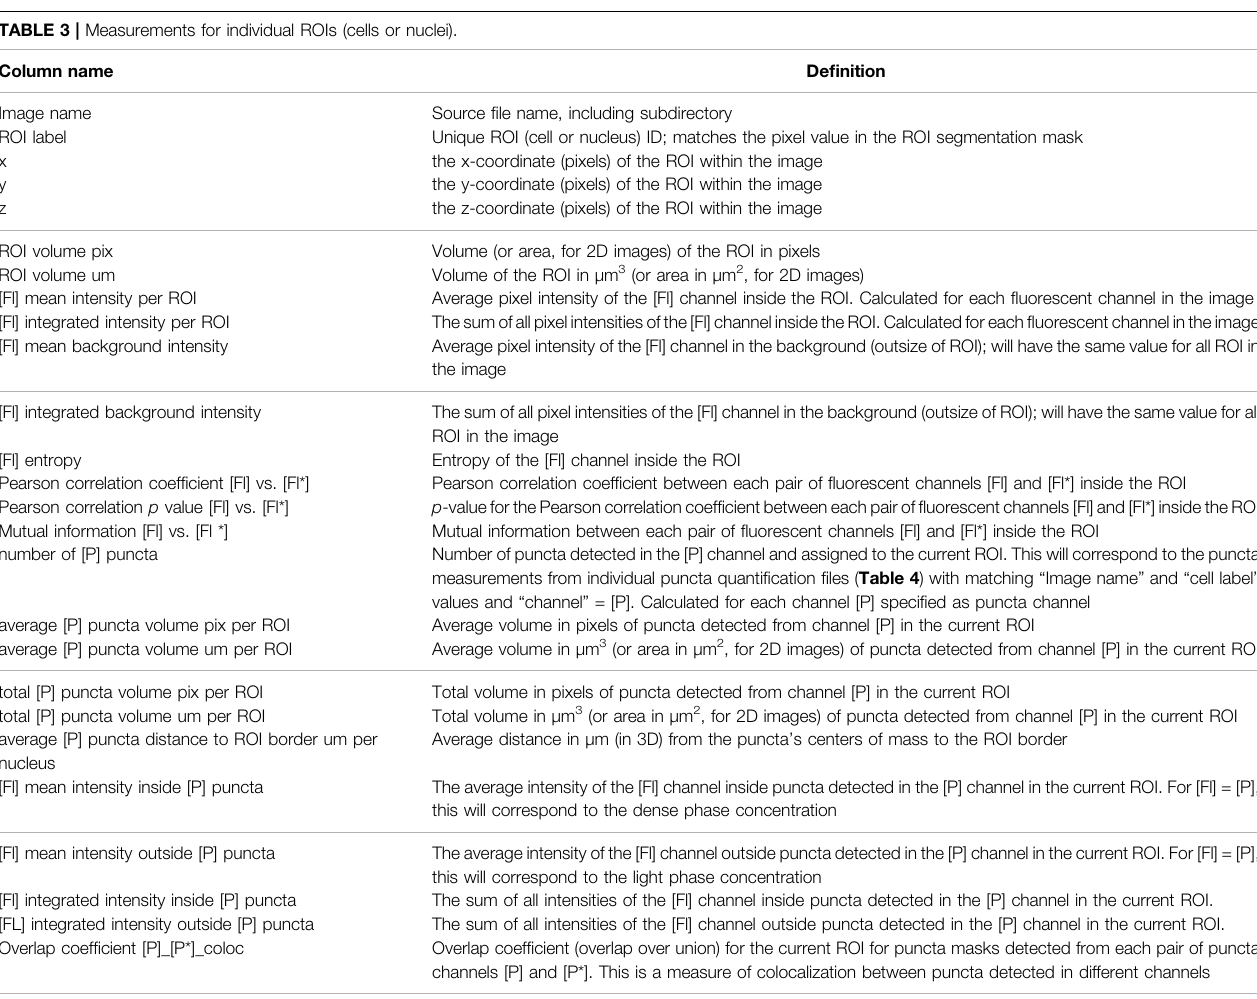
TABLE 3 | Measurements for individual ROIs (cells or